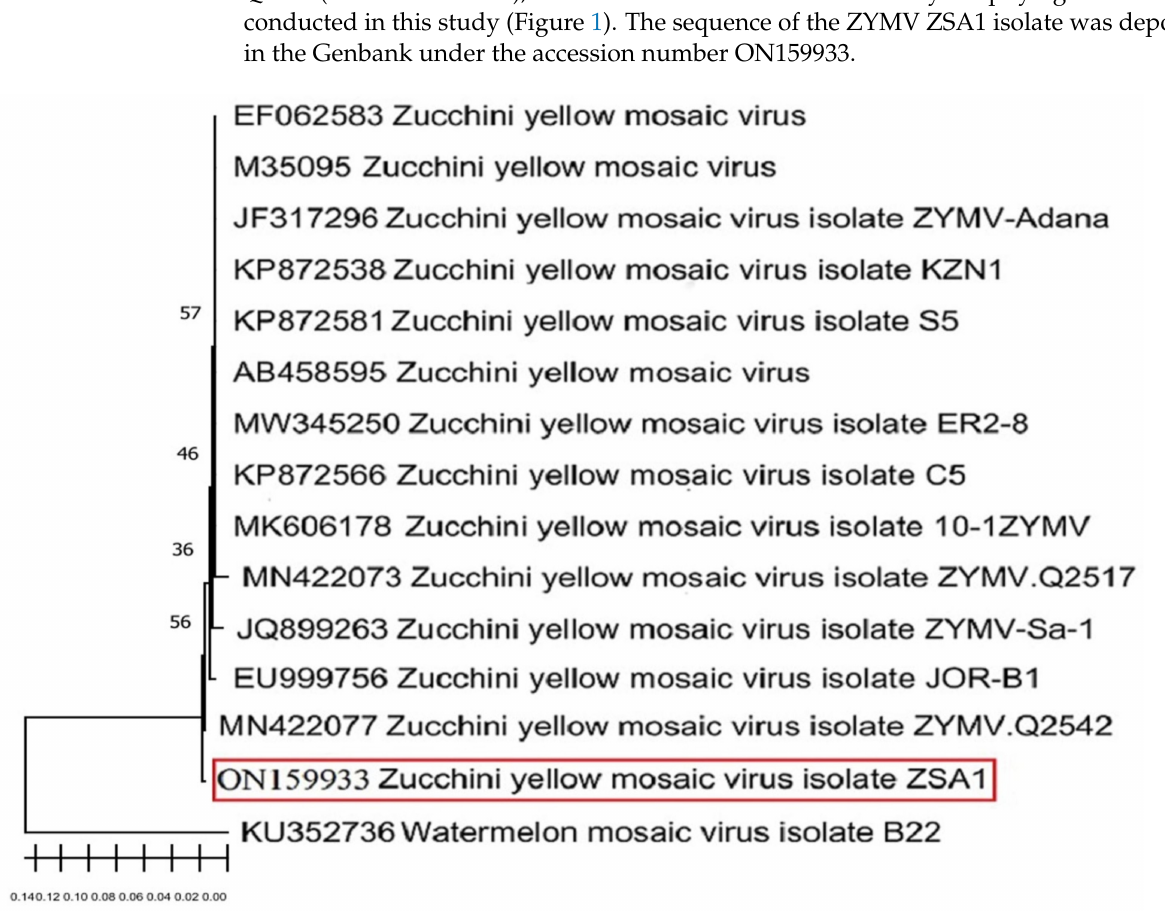
Figure 1. A neighbor-joining phylogenetic tree was constructed based on the nucleotides sequences of Zucchini yellow mosaic virus isolate obtained in this study (ZSA1) and those reported in the